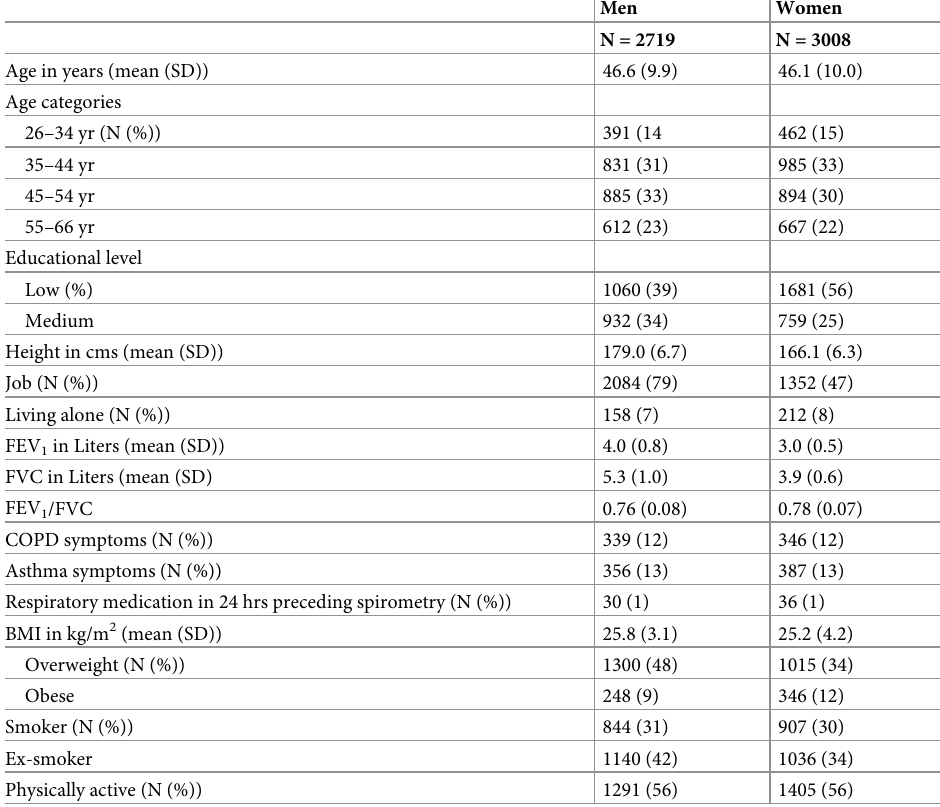
Table 1. Baseline sociodemographic, respiratory health, and lifestyle characteristics of men and women in the Doetinchem Cohort Study.